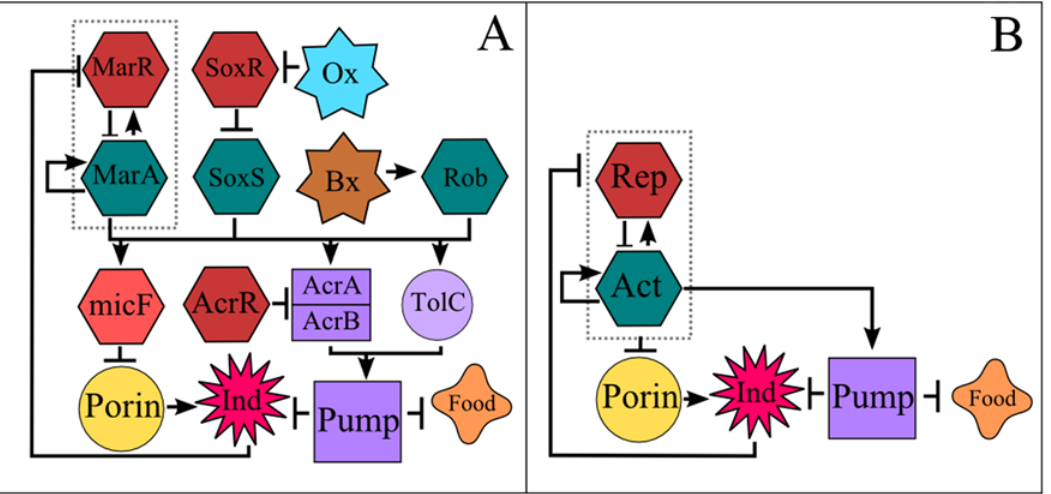
Fig 1. Efflux Pump Regulatory Network. Arrows indicate positive regulation. Blunt arrows indicate repression. A) Literature base reconstruction of the AcrAB-TolC efflux pump regulatory network of Escherichia coli as reported on [9]. B) Simplified version of the AcrAB-TolC efflux pump regulatory network (EPRN). The activator (Act) and repressor (Rep) are two Transcriptional Factors that belong to the same transcriptional unit (EPRN operon, indicated by the dashed line). When the repressor occupies its DNA binding site, the expression of the operon is restrained. Nonetheless, when the antibiotic (or inducer, Ind ) enters the cell, it inactivates the repressor by binding to it, allowing the operon to be actively transcribed, promoting the production of pumps and decreasing the synthesis of porins (this last process is known to occur through an intermediary). Both food and inducer are expelled by the efflux pump system. In the population model, a reduction in food concentration implies an increase in the division